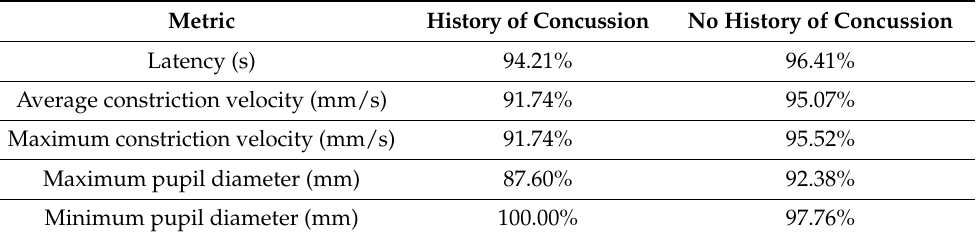
Table A3. Percentage of cases with a history of concussion compared with those without a history (total concussed, N = 177). No significant differences were found between groups for each PLR metric.